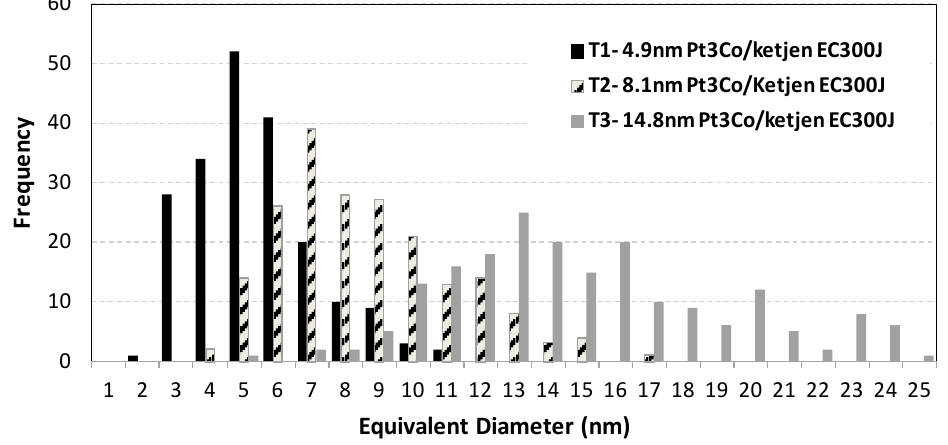
Figure 12. Particle size distributions of annealed Pt 3 Co cathode catalysts determined by